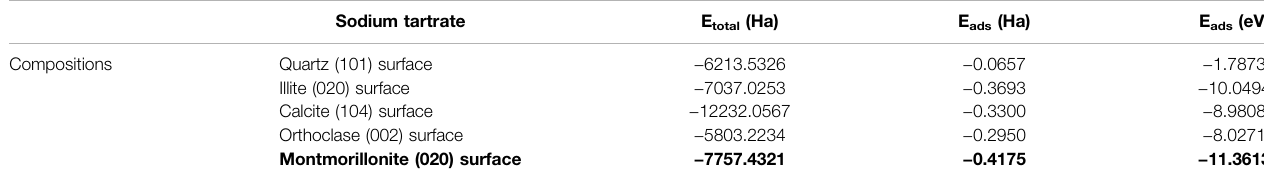
TABLE 3 | Calculation results of the adsorption energy between different minerals of bentonite and sodium tartrate (1 Ha = 27.2114